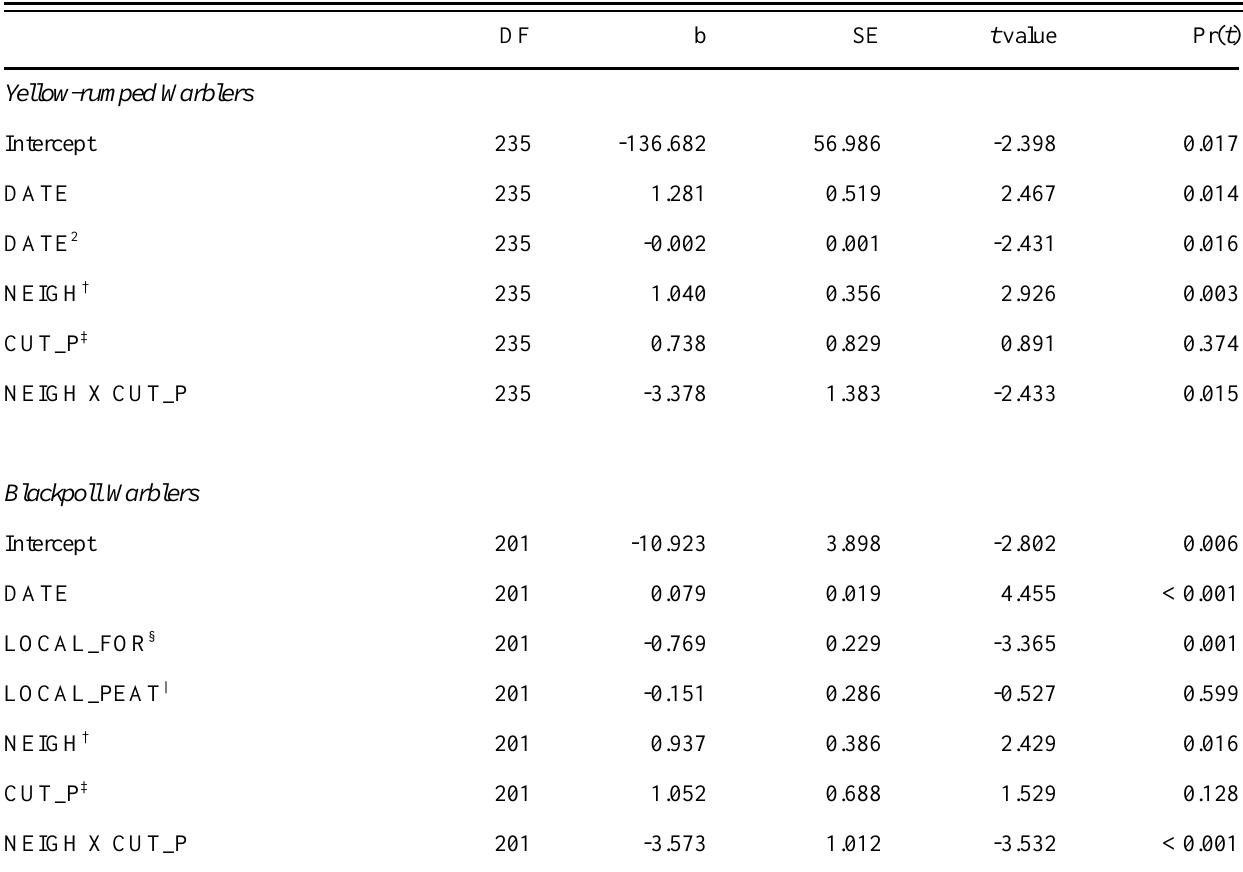
Table 2. Parameter estimates for significant predictors from best-fit final linear mixed-effects models used to explain juvenile Yellow-rumped and Blackpoll Warbler movement